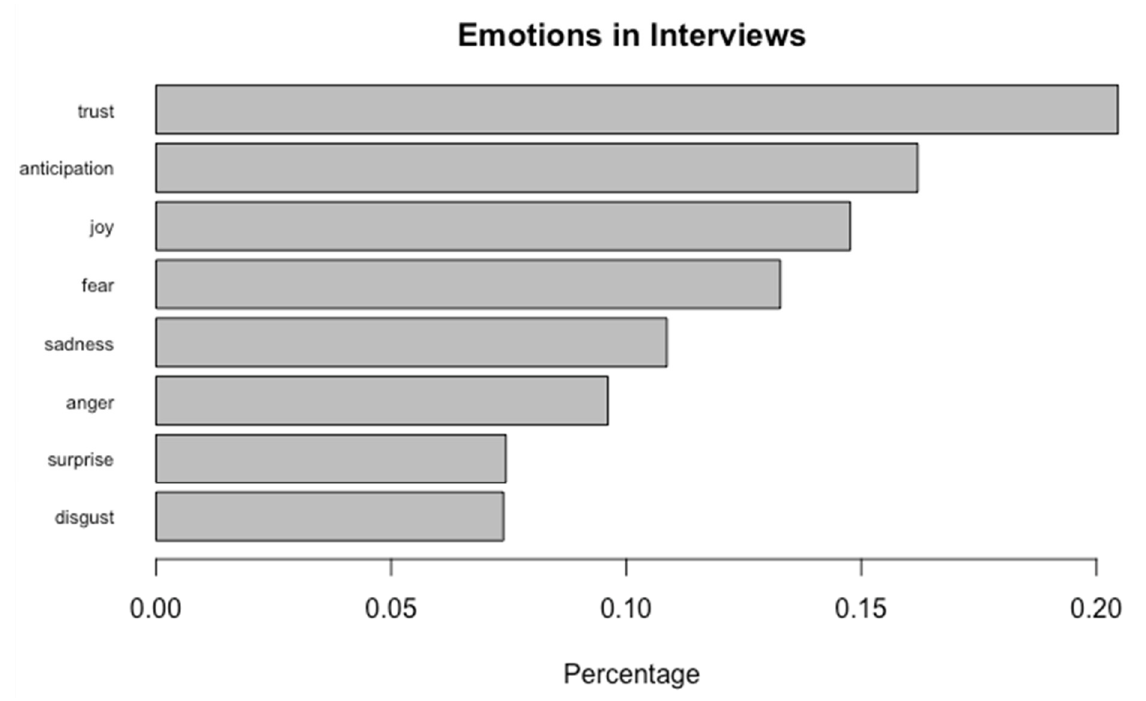
Figure 1. Emotions present in the 300 pages of interview data. 20.4% of sentences were labeled as trust, 16.2% as anticipation, 14.7% as joy, 13.3% as fear, 10.9% as sadness, 9.6% as anger, 7.5% as surprise, and 7.4% as disgust.